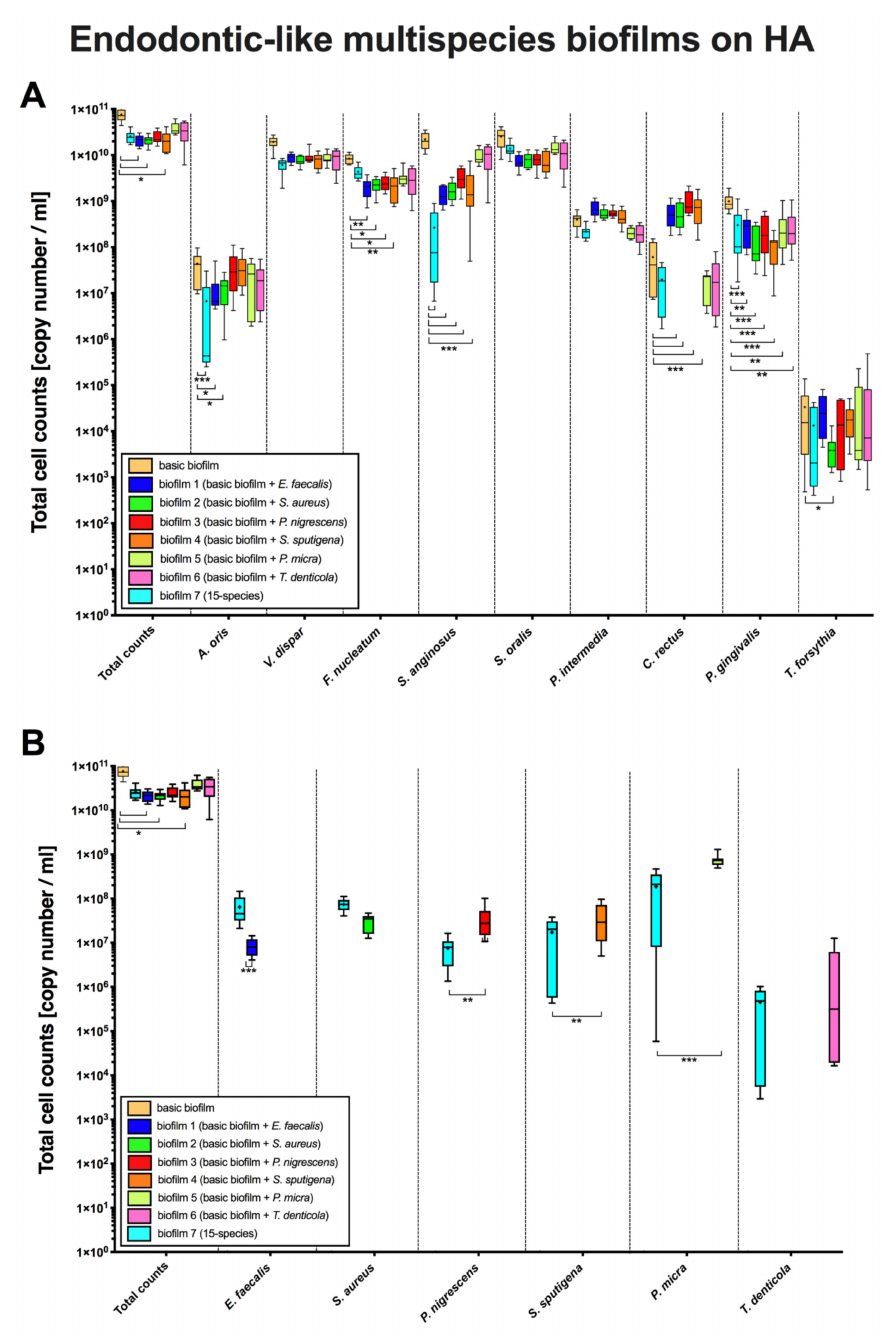
Figure 2. Boxplots demonstrating cell counts per endodontic-like biofilm on pellicle-coated hydroxyapatite discs after analysis by qPCR. To form endodontic-like multispecies biofilms, a total of six bacterial species were added separately to a “basic” nine-species subgingival biofilm. x -axis of panal ( A ) shows the strains of the “basic biofilm” (in the first column total counts (beige) as a control group are shown), while x -axis of panal ( B ) shows in the first column total counts (beige) again, as well as the strains of the endodontic species ( E. faecalis (blue), S. aureus (dark green), P. nigrescens (red), S. sputigena (orange), P. micra (light green) and T. denticola (pink)). Statistically significant di ff erences between the biofilm with additional strains and the control group (“basic biofilm” or endodontic-like biofilm) is marked with 1–4 asterisks (* p < 0.05; ** p < 0.01; *** p < 0.001). The internal line represents the median; the whiskers indicate minimum and maximum. The p values ( p ≤ 0.05) of the significantly di ff erent data are provided. Data derive from three independent experiments, each represented in triplicate biofilm cultures ( n =